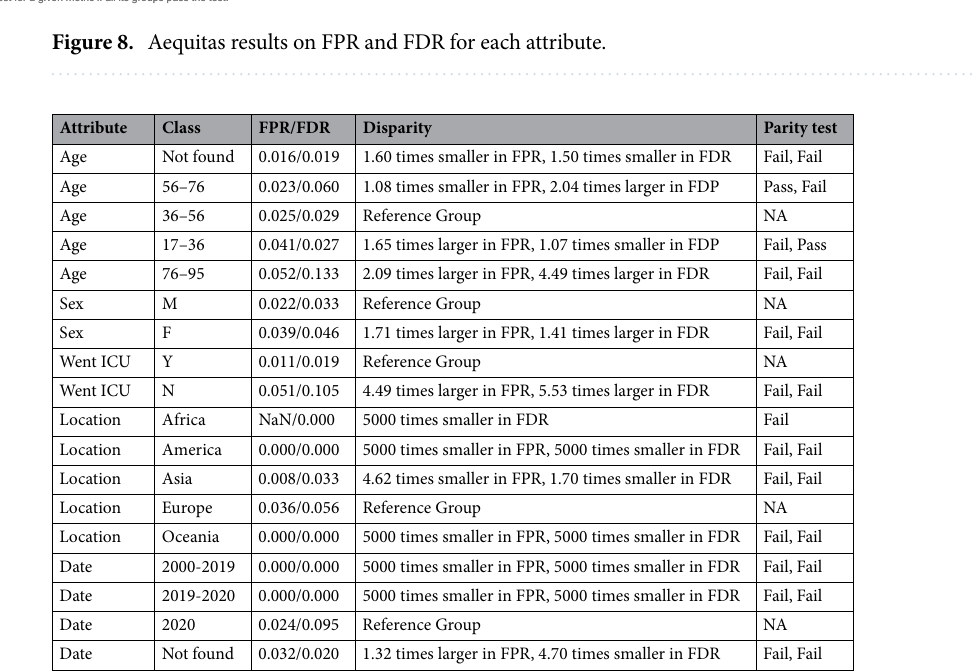
Table 3. FPR and FDR on each attribute detailed to complement Fig.